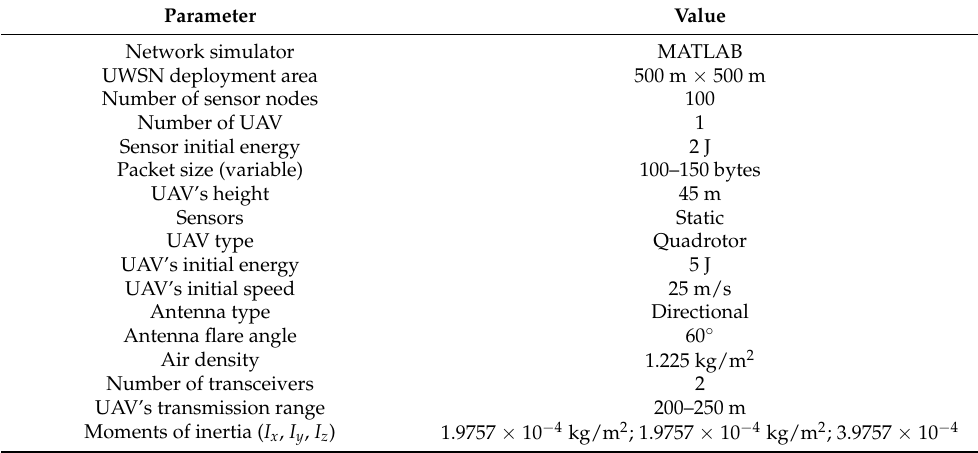
Table 3. Simulation